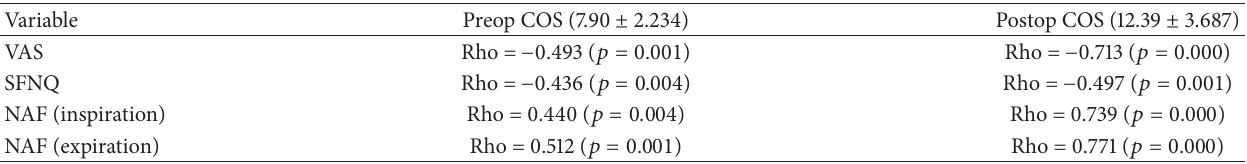
Table 2: Correlation matrix between combined olfactory score on the obstructed side of the nose and rest of the variables, both pre- and